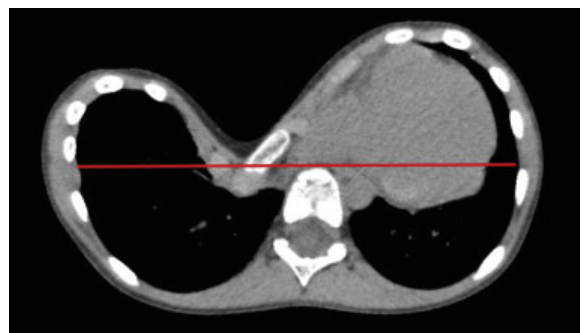
Fig. 2 Patient ’ s chest imaging prior to surgical correction. Chest computed tomography showing the sternum depression is below anterior vertebral column line (red